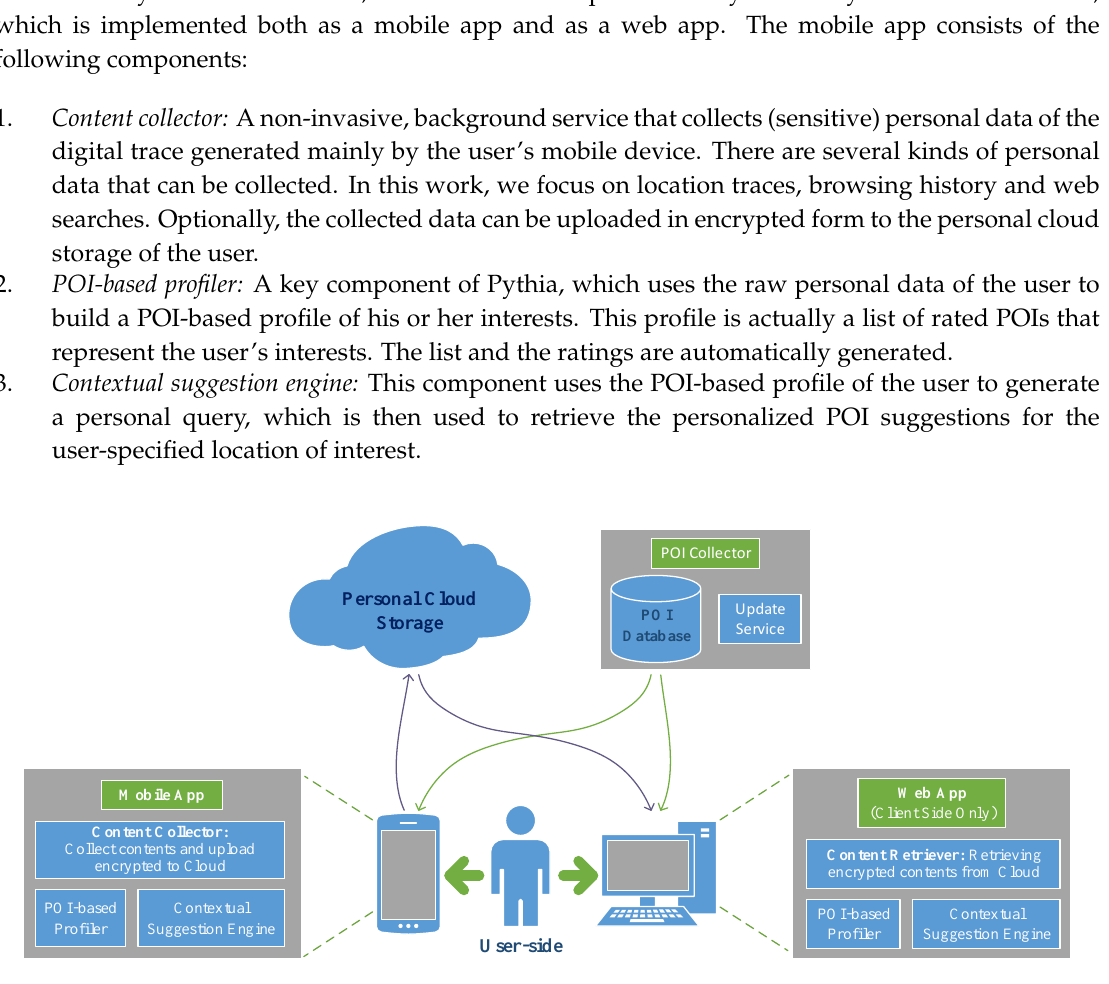
Figure 1. Overview of the architecture of the Pythia